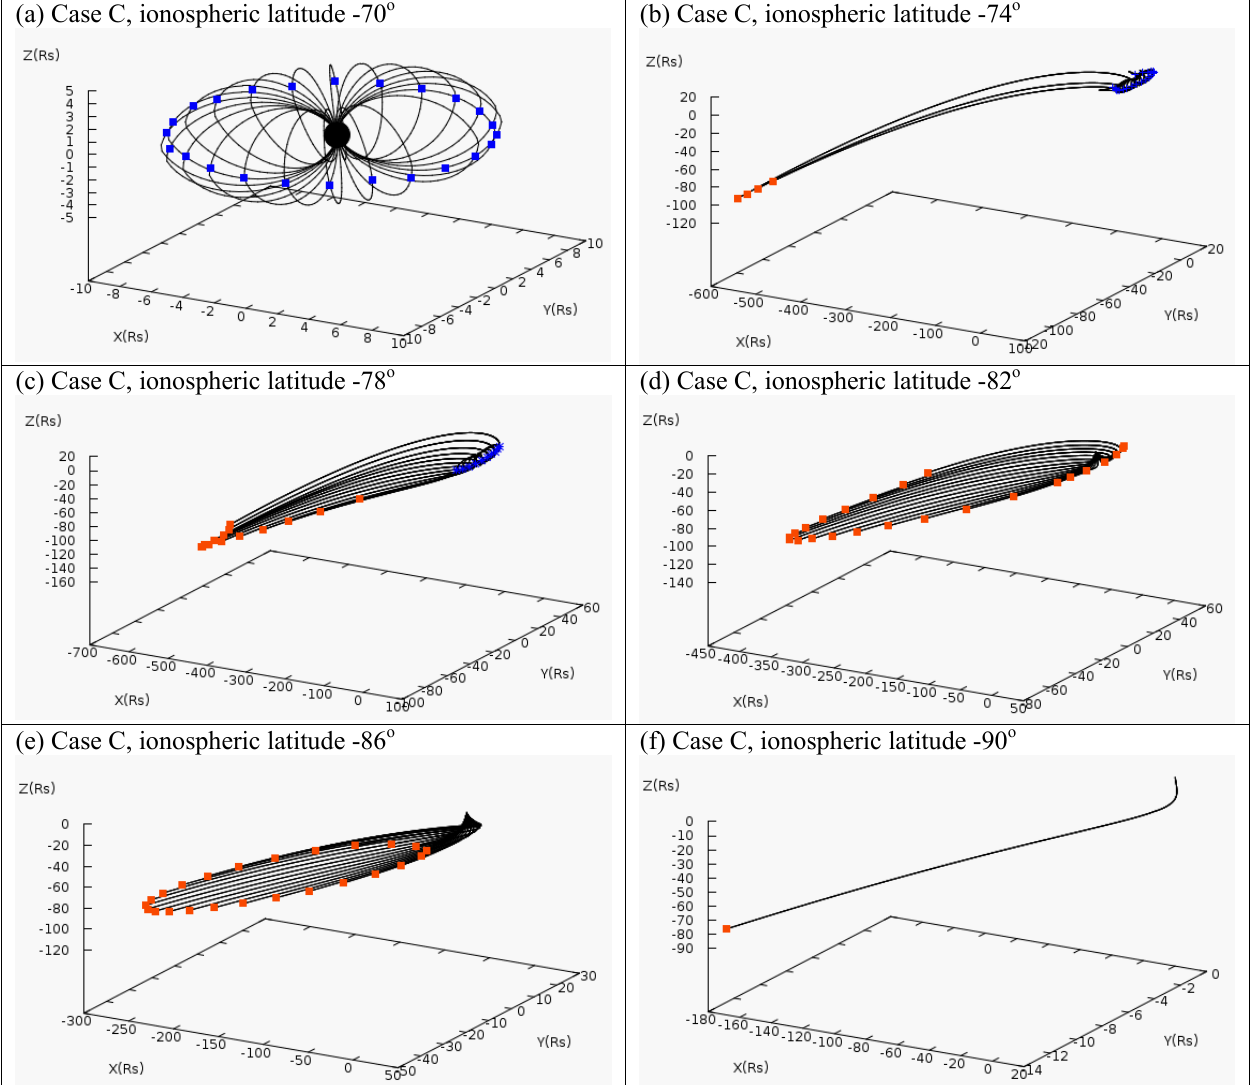
Fig. 3. Plots showing model magnetic field lines whose ionospheric footprints lie at constant southern latitudes, for the field model corre- sponding to case C with IMF penetration coefficient k s = 0 . 2. Panels (a) to (f) show results for latitudes from − 70 ◦ to − 90 ◦ , respectively, at steps of 4 ◦ . The longitude step between each field line corresponds to 1h of LT. Note the varying X-Y spatial scales in the various panels. Blue symbols mark intersections of the field lines with the planet’s equatorial plane, while red symbols mark intersections with the southern magnetopause. The solid black circle shows the position of